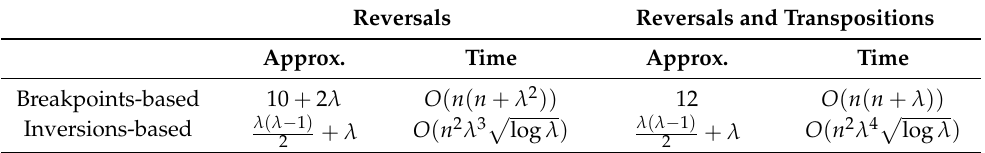
Table 1. Summary of the approximation results for the problems considering signed permutations. The columns “Approx.” and “Time” refer to the theoretical approximation factor and the worst-case complexity time, respectively. Reversals Reversals and Transpositions Approx. Time Approx. Time Breakpoints-based